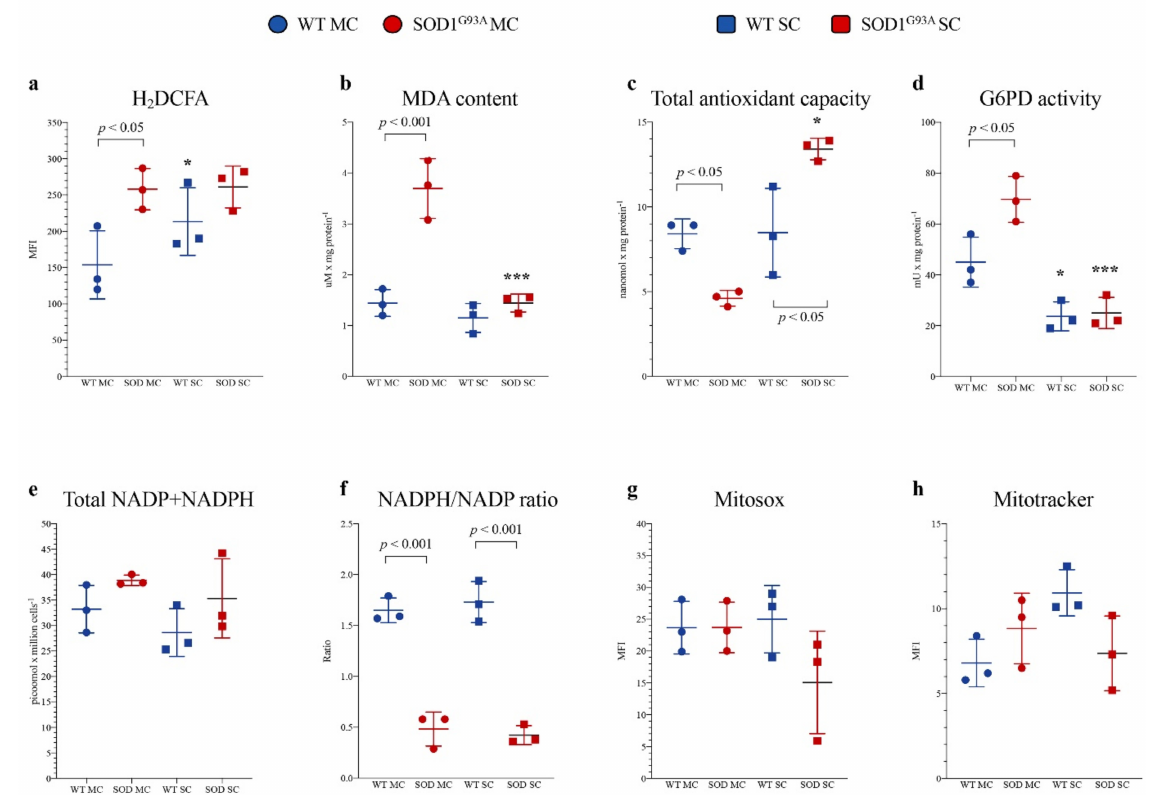
Figure 2. Astrocyte antioxidant response and oxidative stress. ( a ) ROS levels measured using H 2 DCFDA mean fluorescence index (MFI), ( b ) malondialdehyde content (MDA), ( c ) antioxidant capacity and ( d ) G6PD activity in wildtype (blue) and SOD1 G93A (red) astrocytes harvested from motor cortex (MC) and spinal cord (SC). ( e ) NADPH level in wildtype (light blue) and SOD1 G93A (pink) astrocytes and NADP + level in wildtype (blue) and mutated cells (red). ( f ) NADPH/NADP + ratio in wildtype (blue) and SOD1 G93A (red) astrocytes. ( g ) Mean fluorescence intensity (MFI) of MitoSOX and ( h ) MitoTracker in wildtype (blue) and SOD1 G93A (red) astrocytes harvested from MC and SC. Data are shown as the mean ± SD. n = 3 experiments per group, with each value defined in triplicate. * = p < 0.05, *** = p < 0.01 (WT SC astrocytes vs. WT MC astrocytes and SOD1 G93A SC astrocytes vs. SOD1 G93A MC